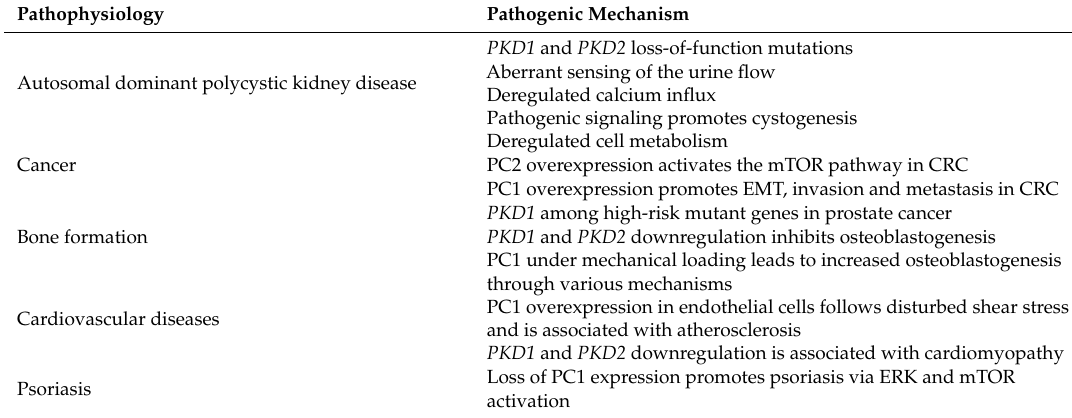
Table 1. The impact of polycystin deregulation in certain